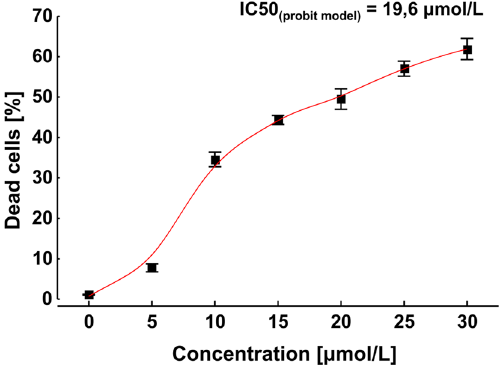
Figure 2. The percentage of dead cells after 72-h exposure to various concentrations of the 12-5-12 surfactant. An initial cell concentration at the level of 10.05 × 10 7 cells/mL. The data points show a mean value and a standard deviation from three independent treatments. IC50 value was estimated with the probit model.